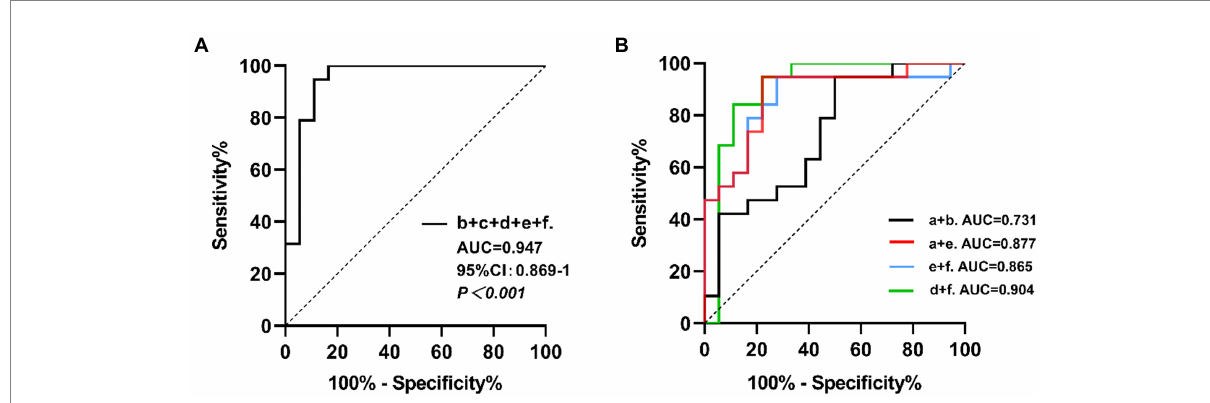
FIGURE 4 The ROC curves for the combined MIBG scintigraphy uptake ratio. a : the left parotid gland uptake ratio in early images; b : the left submandibular gland uptake ratio in early images; c : the right submandibular gland uptake ratio in early images; d : the left submandibular gland uptake ratio in delayed images; e : the heart uptake ratio in early images; f : the heart uptake ratio in delayed images. (A) The b + c + d + e + f combined, AUC = 0.947, 95% CI: 0.869–1, p < 0.001. (B) The a + b combined, AUC = 0.731, 95% CI: 0.568–0.894, p = 0.0062; the a + e combined, AUC = 0.877, 95% CI: 0.763– 0.991, p < 0.001; the e + f combined, AUC = 0.865, 95% CI: 0.742–0.989, p < 0.001; the d + f combined, AUC = 0.904, 95% CI: 0.789–1, p <